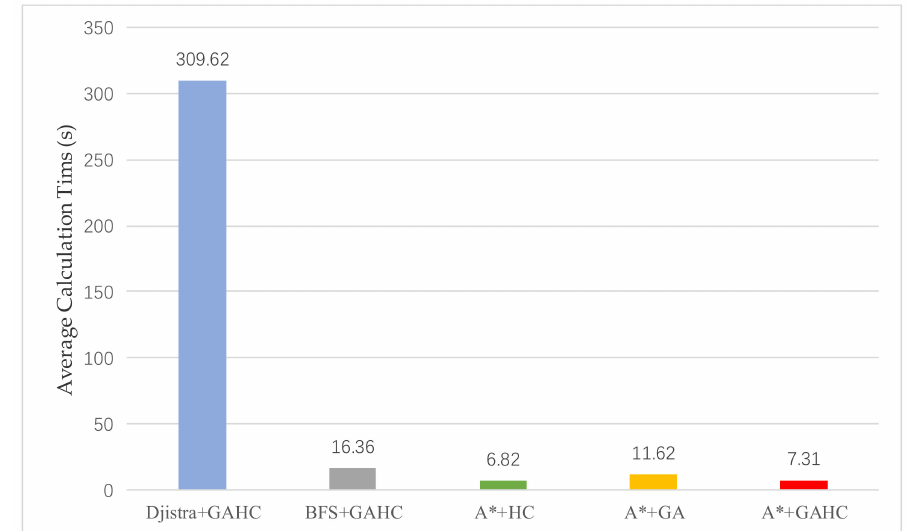
Figure 16. Average calculation time in various algorithms.